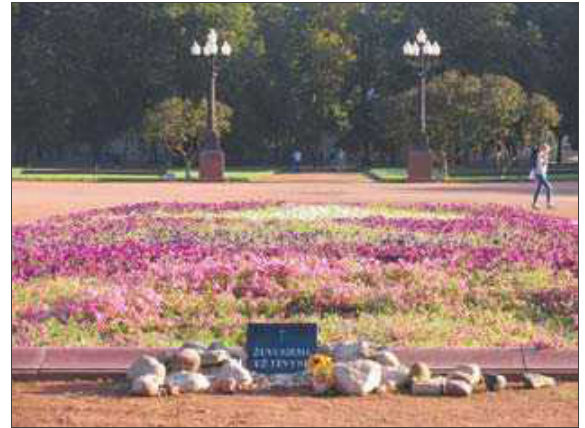
Fig. 10. contemporary view of the square